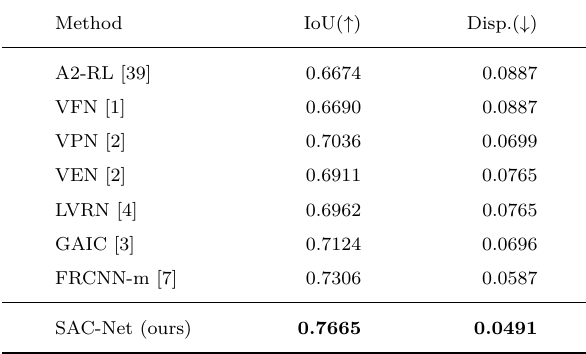
Table 2 Results on the SACD dataset test set